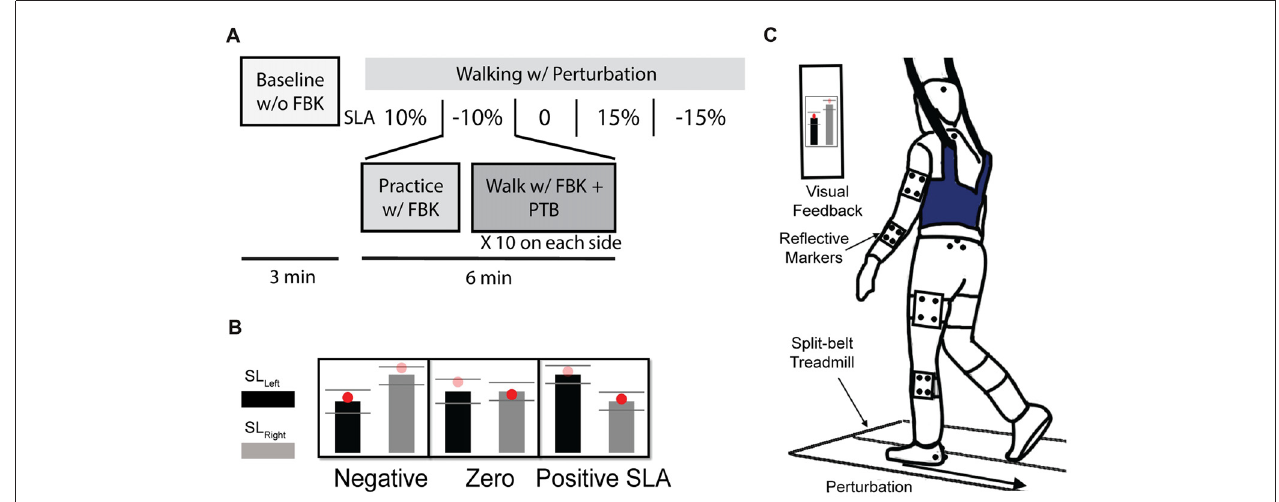
FIGURE 1 | (A) Experiment protocol. Participants completed a total of six trials. Participant’s Baseline step length asymmetry was collected during the first 3-min baseline trial without visual feedback. Then, they were instructed to complete a randomized sequence of five 6-min trials with target step length asymmetries of 0%, ± 10% and ± 15%. During each visual feedback trial, the participant first practiced with feedback for 1 min, then 10 perturbations were randomly applied at foot strike on each side. (B) Visual feedback for three of the five trials of step length asymmetry are shown. (C) Experimental setup. Participant were instructed to walk